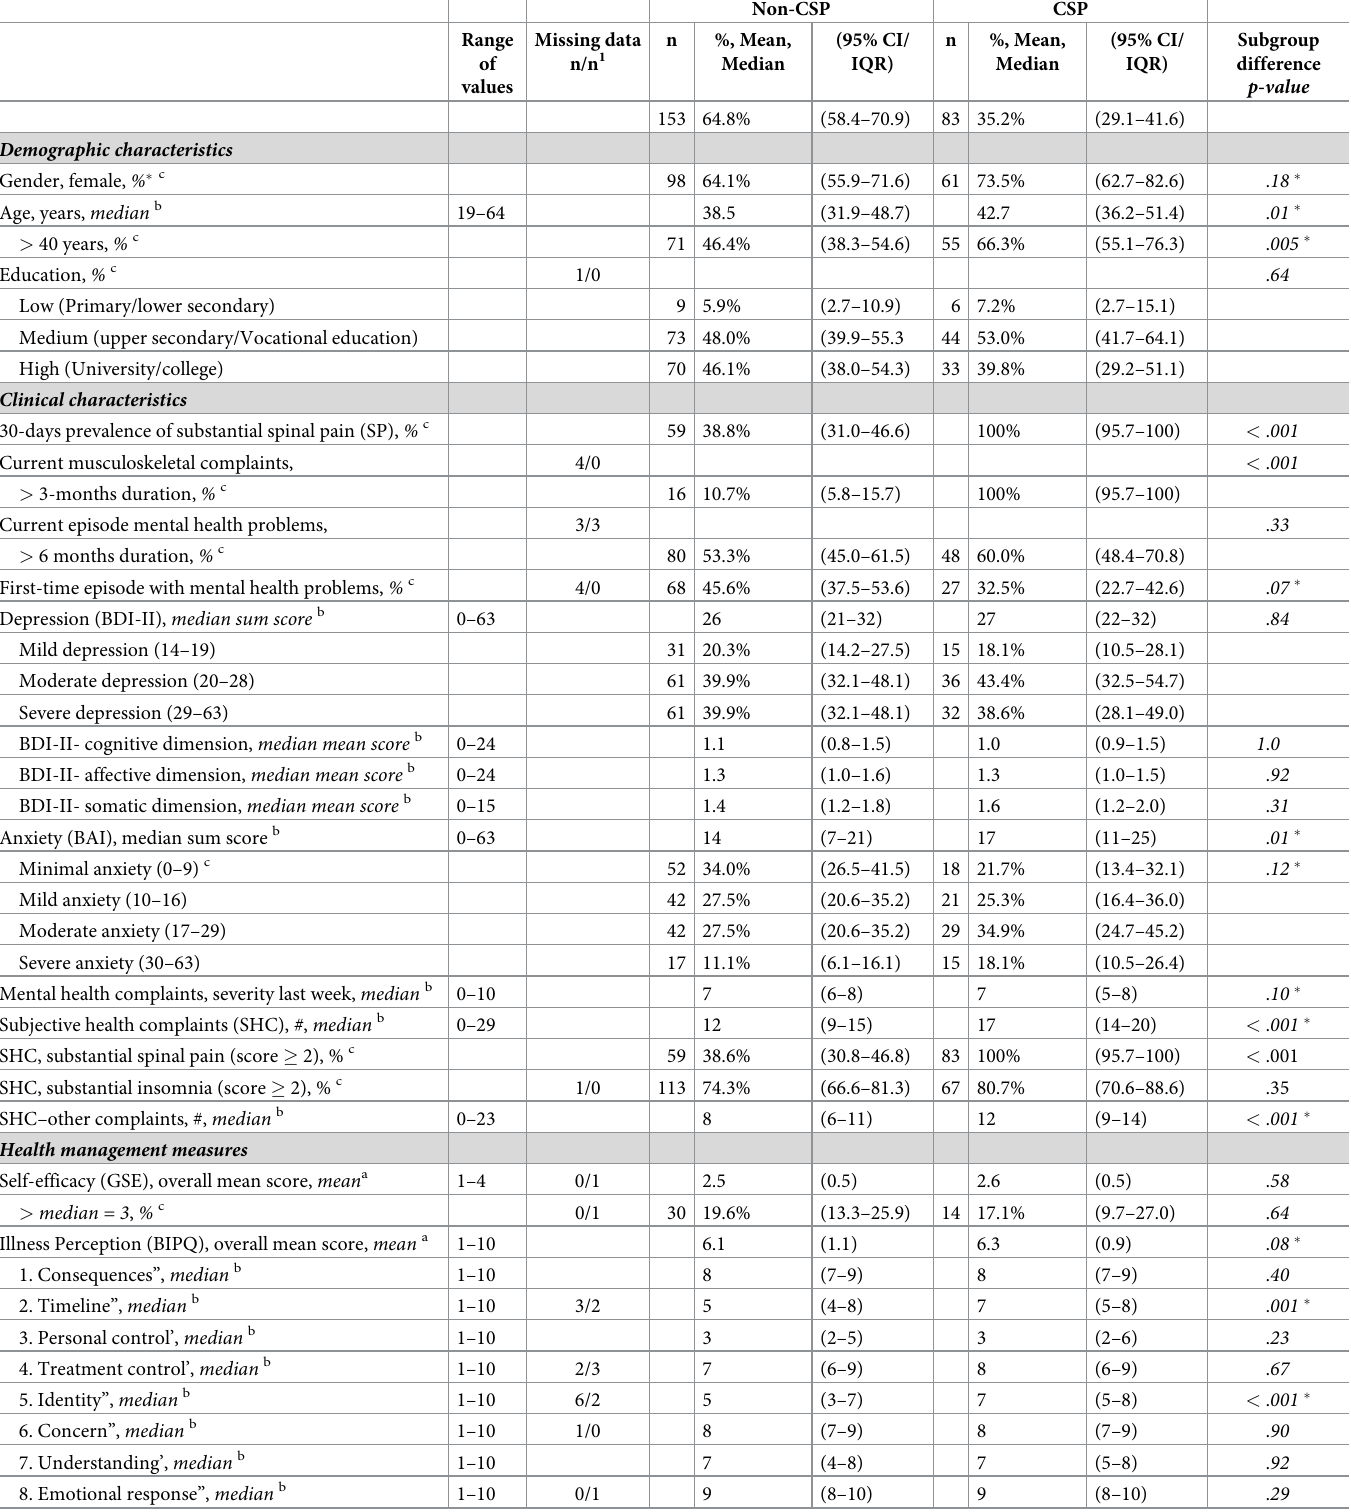
Table 1. Summary statistics of demographics, clinical characteristics, health management and work measures at baseline, stratified for the presence of